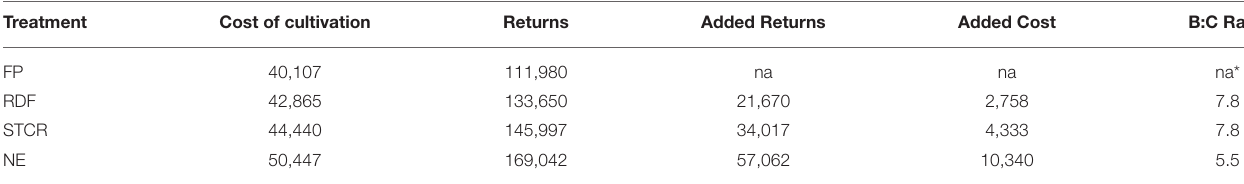
TABLE 4 | Effect of nutrient management practices on cultivation costs (Rs. ha − 1 ), returns (Rs. ha − 1 ), the added costs, and added returns (Rs. ha − 1 ) over the FP treatment and the Benefit:Cost (BC) ratio.